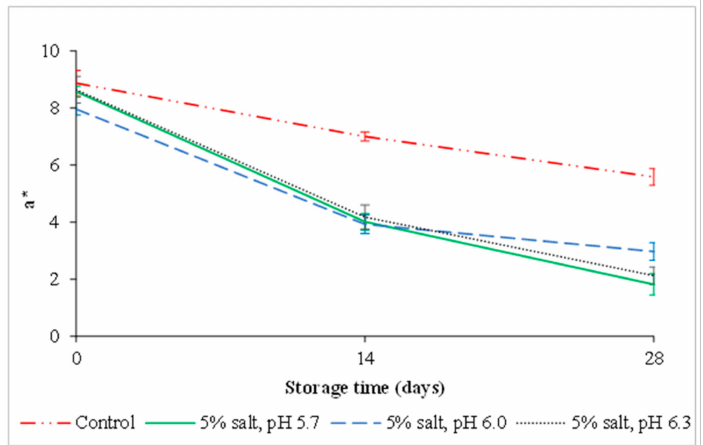
Figure 4. The effect of treatment on a* (CIE red(+)/green( − ) colour attribute [32]) of frozen-thawed liquid egg yolk. Data are presented with mean ± standard deviation.